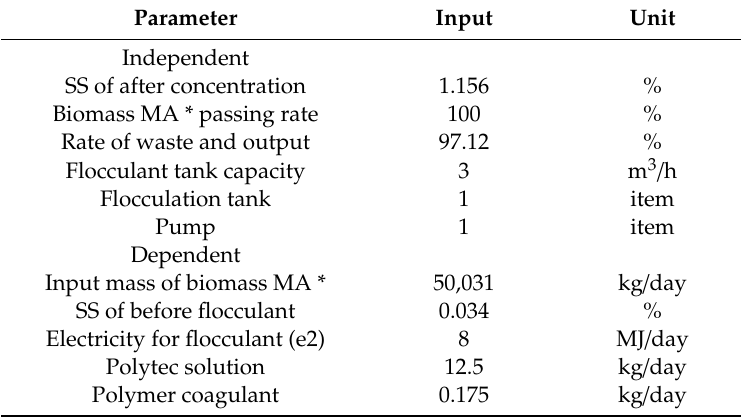
Figure 8. Mass balance of microalgae oil production in drum filtration sub-unit per 1 m 3 . Table 7. Parameters set at filtration sub-unit per 50 m 3 /day. Parameter